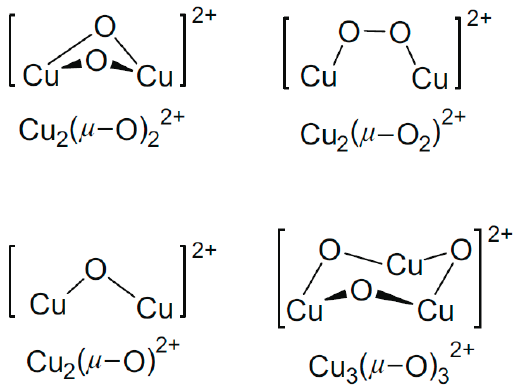
Figure 14. Cu ‐ oxo complexes proposed as the active sites for CH 4 activation in Cu ‐ containing zeo ‐ Figure 14. Cu-oxo complexes proposed as the active sites for CH 4 activation in Cu-containing zeolites. lites. Reproduced with permission from [80]. Copyright 2016 Elsevier. Reproduced with permission from [80]. Copyright 2016